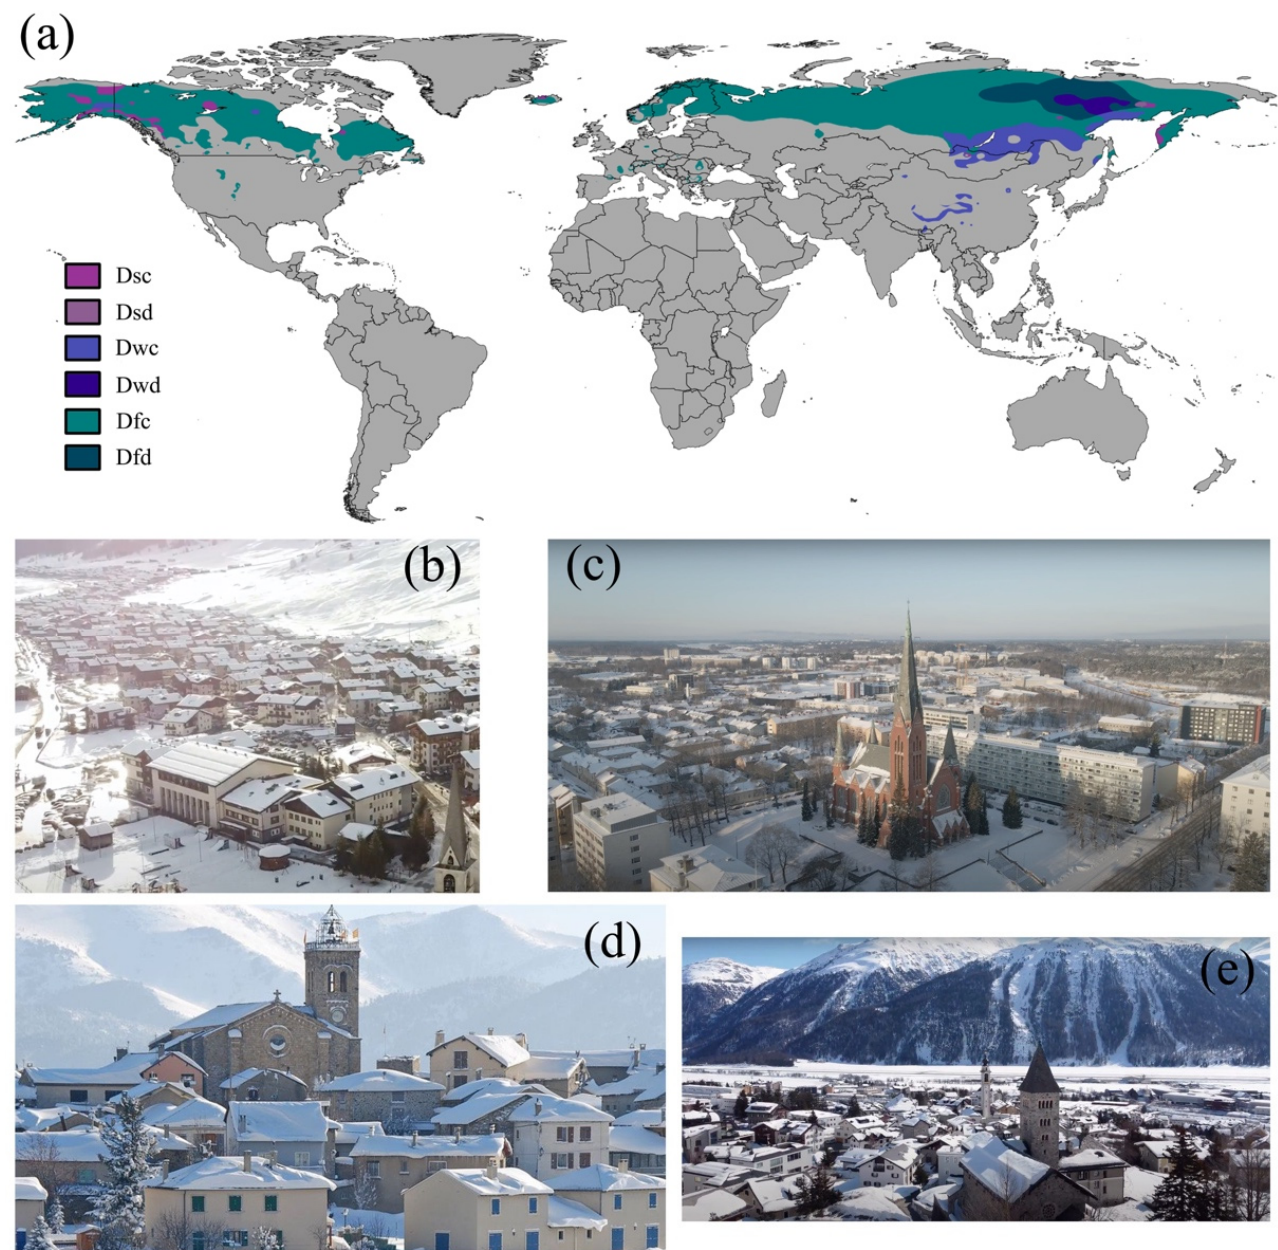
Figure 1. ( a ) Worldwide distribution of subarctic climate according to Köppen [1]; ( b ) Livigno (Italy); ( c ) Turku (Finland); ( d ) Les Angles (France); ( e ) Samedan (Switzerland) during winter.